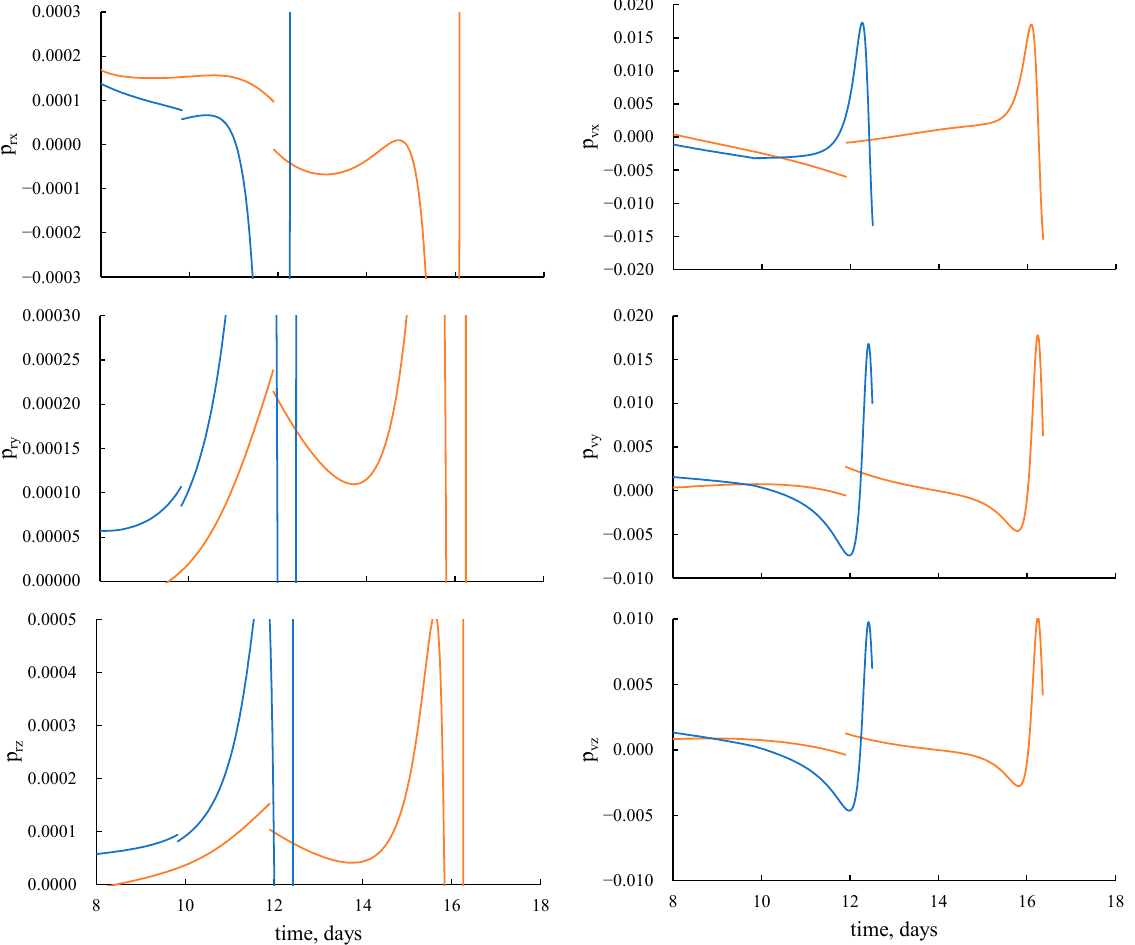
Figure 4. Variation of the adimensional values of costate variables on the 4-revolution LP-trajectory to the Moon. The magnitudes of discontinuity of the costate variables to the vector r at the junction p p = − 2.0424 ∙ 10 − 5 , moment are + − − rx rx the 4-revolution trajectory,